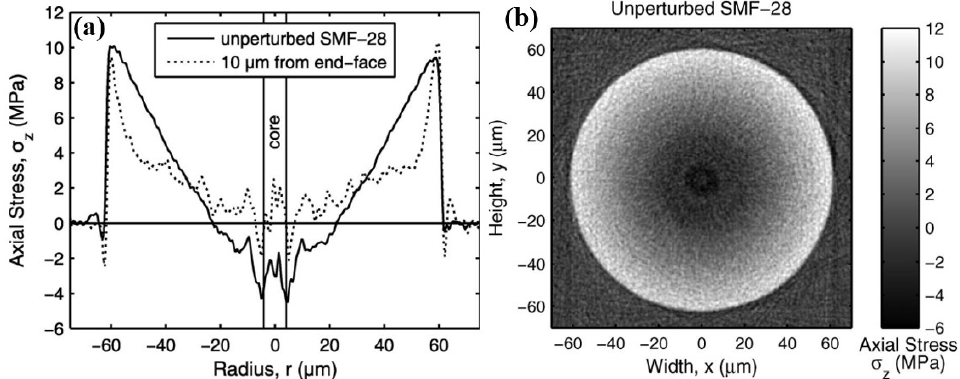
Figure 3. Reference residual stress distribution of Corning SMF−28: ( a ) one−dimensional distribution of axial residual stress; ( b ) two−dimensional distribution of residual stress in fiber cross section [16].